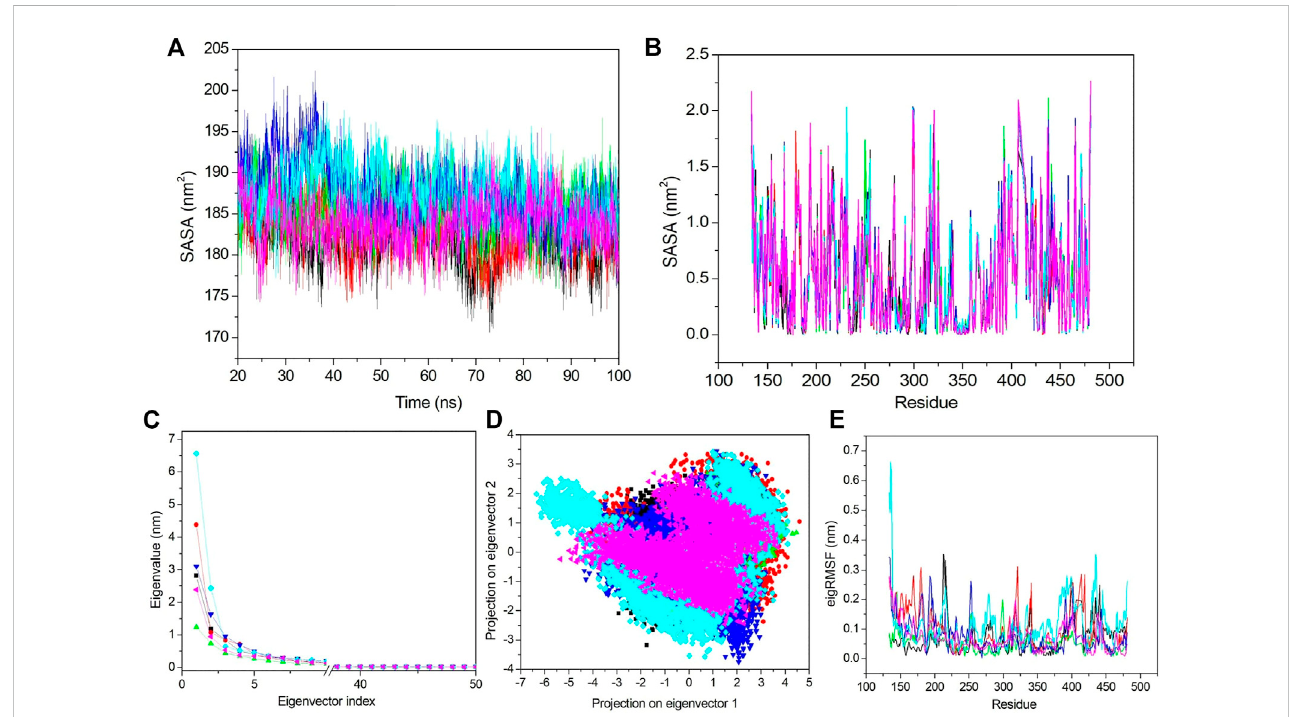
FIGURE 7 SASA and PCA. (A) SASA value vs . the time for all the systems. (B) SASA value based on residues. (C) First 50 PCs vs . the eigenvalue for all the systems. (D) 2D projection of the fi rst two principal components on the phase space. (E) Obtained eigRMSF from the fi rst eigenvector vs . the residues. All the calculations have been carried out from the last 80 ns trajectory at 300 K. The black, red, green, blue, cyan, and pink colors represent apo – DYRK1A, DYRK1A – 4E3, DYRK1A – ZINC2123081, DYRK1A – ZINC3843365, DYRK1A – ZINC5220992, and DYRK1A – ZINC68569602,